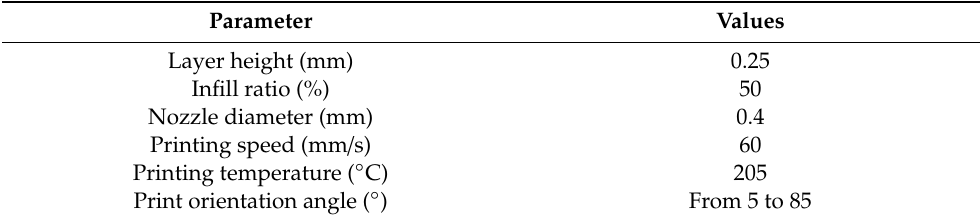
Table 1. Printing parameters of the experimental tests.